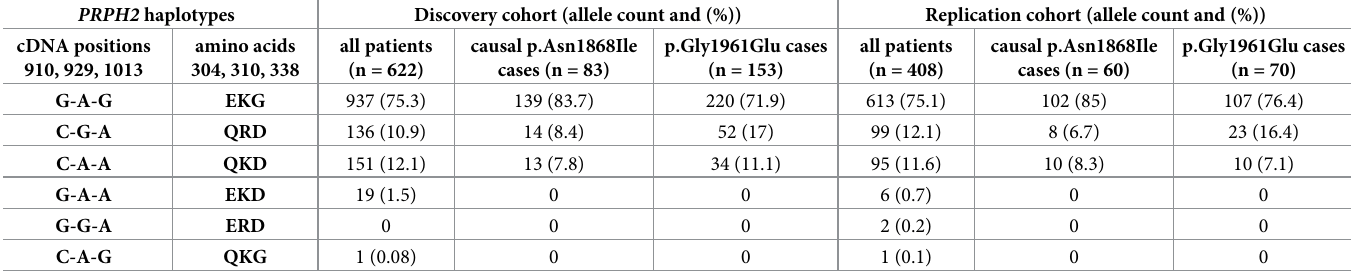
Table 3. Haplotype frequencies in the 3’ end of the PRPH2 gene in ABCA4 disease cohorts and genetically determined disease subgroups. For PRPH2 , nucleotide positions and protein translation correspond to CCDS4871.1 and NP_000313.2, respectively; for ABCA4 , CCDS747.1 and NP_000341.2, respectively. Nucleotide number- ing uses the A of the ATG translation initiation start site as nucleotide 1. The haplotype frequencies were determined directly from sequence data. PRPH2